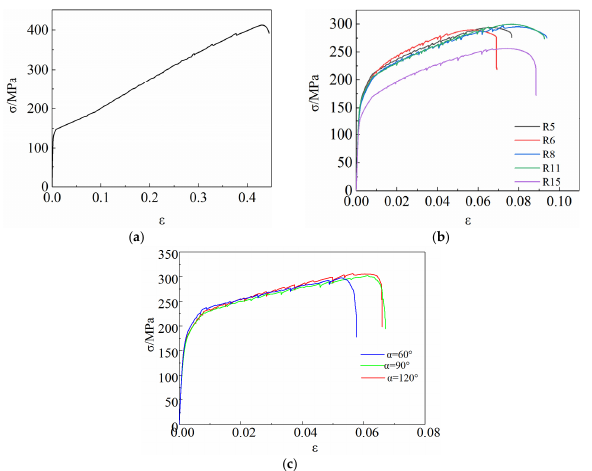
Figure 1. True stress-strain curves of 6061 aluminum alloy sample. ( a ) Circular arc tensile sample. ( b ) Arc-shaped notched tension sample. ( c ) V-shaped notched tensile sample.